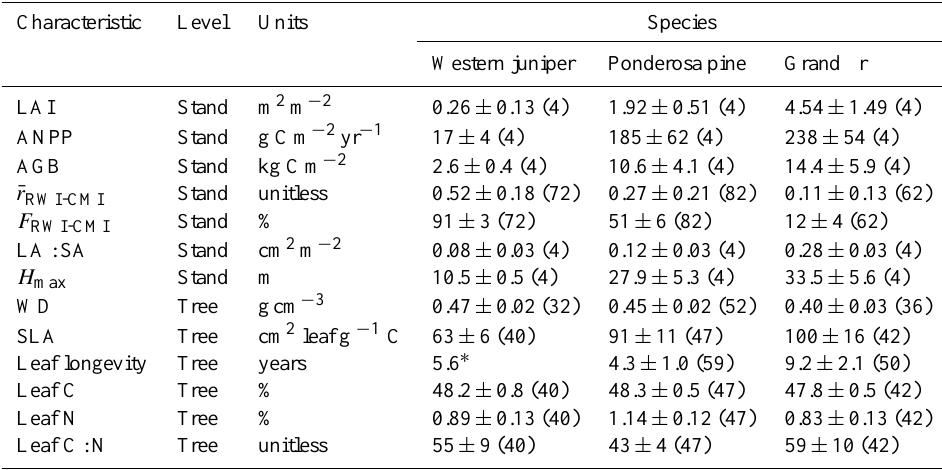
Table 4. Summary of carbon cycling, growth–climate, morphological, and chemical characteristics for three conifer species in the eastern Cascade Mountains, Oregon. Both stand- and tree-level characteristics are included. Excluding specific leaf area (SLA), the full name of each characteristic is given in Table 2. The stand-level characteristics provided for grand fir actually represent an average mixture of two thirds grand fir and one third ponderosa pine. The mean, standard deviation, and sample size are provided for each characteristic. Specific leaf area is presented here in terms of leaf hemisurface area and not projected surface